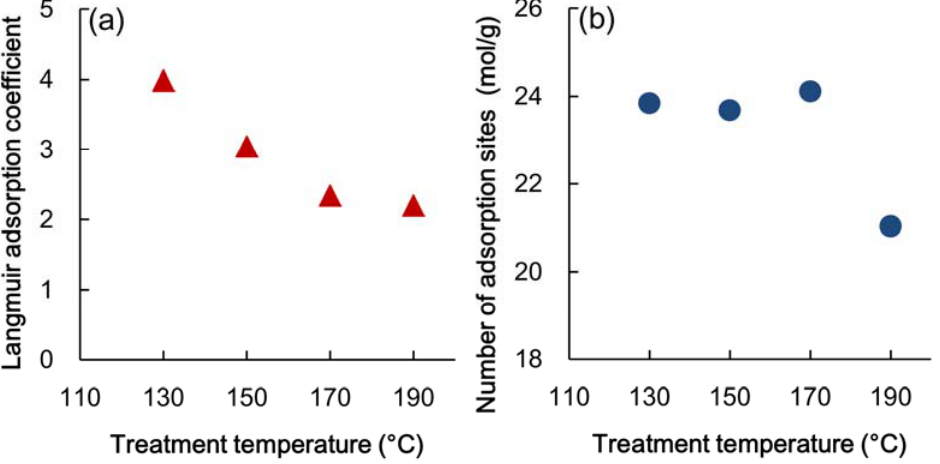
Figure 6. ( a ) Change in adsorption coefficient related to energy of adsorption; ( b ) adsorption sites per unit weight of wood